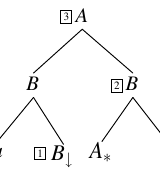
Figure 3: Sample TAG tree marked with diacritics to show the permutation of operable nodes. Note that the node at address 1 is left out of the set of operable sites; it is thus a nonadjoining